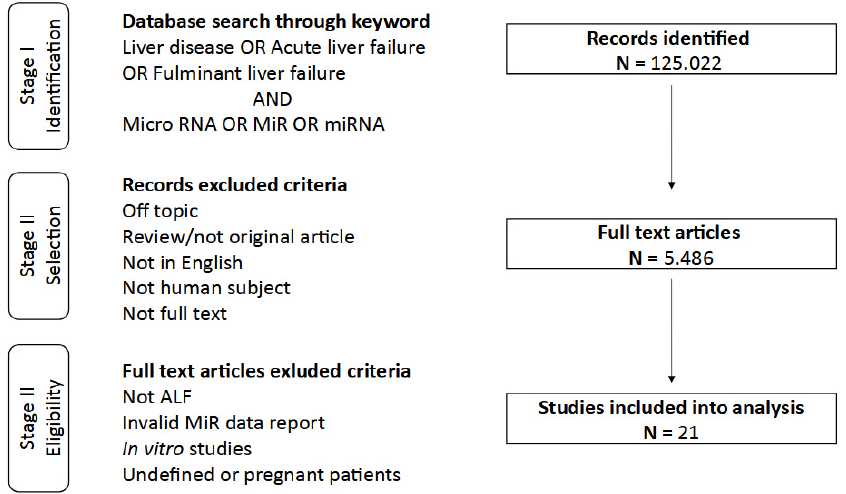
Figure 1. Flow chart of database searching and selection process.